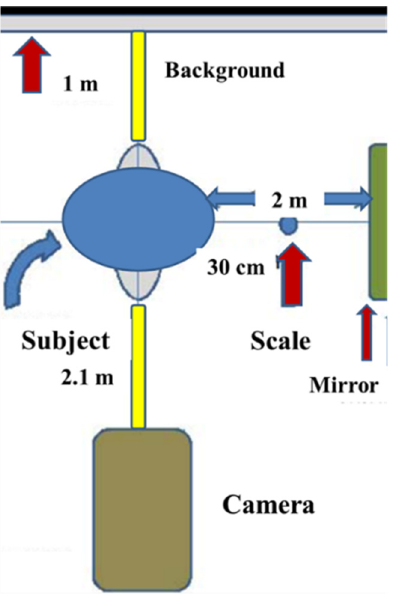
Figure 1. The parameters of the protocol used in the 2D standardized facial photography.